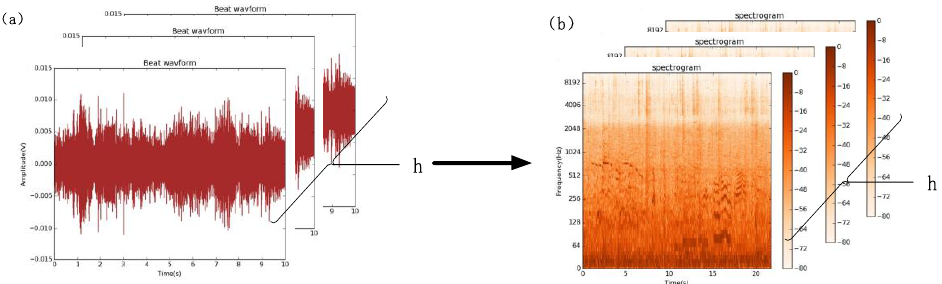
Figure 1. The form of sound data for h channels. When sound is converted into tensor data, for each channel, data is represented as (time_steps, features) two-dimensional time series information, as shown in ( a ). The spectrogram contains the sound’s time-frequency domain information, as shown in ( b ).